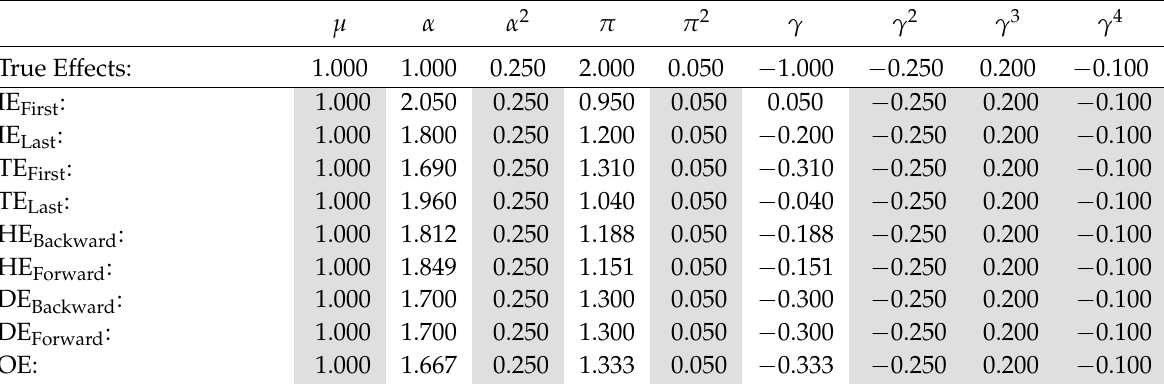
Table 6: Comparison of MP estimators: nonlinear and linear